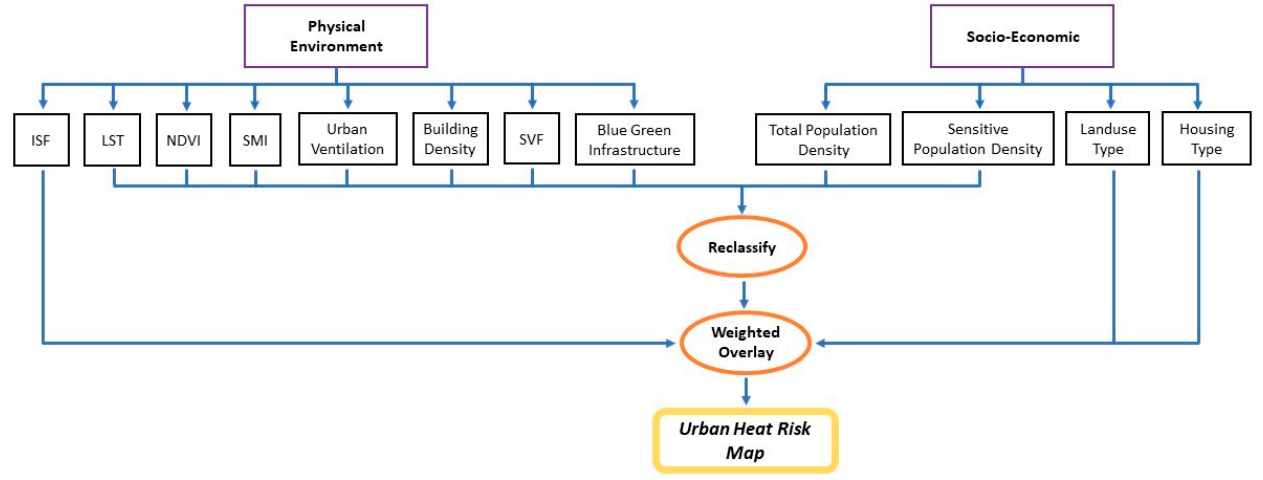
Figure 4. Model builder of heat risk map in ArcMAP 10.6.